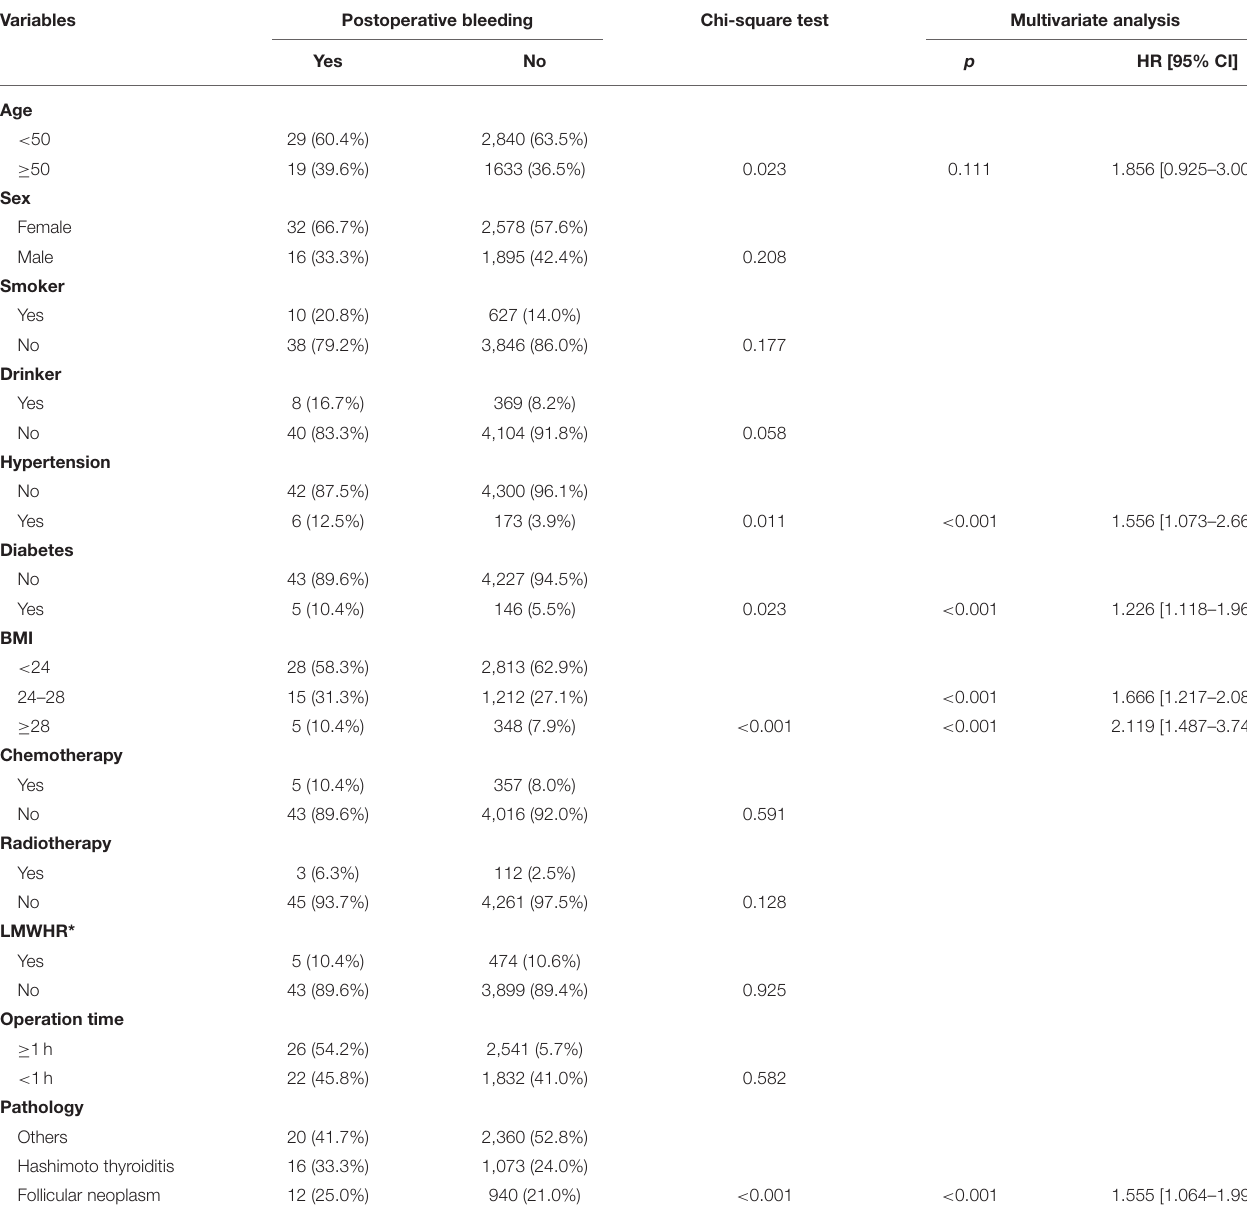
TABLE 2 | Association between clinical pathologic variables and postoperative bleeding in patients with benign disease. Variables Postoperative bleeding Chi-square test Multivariate